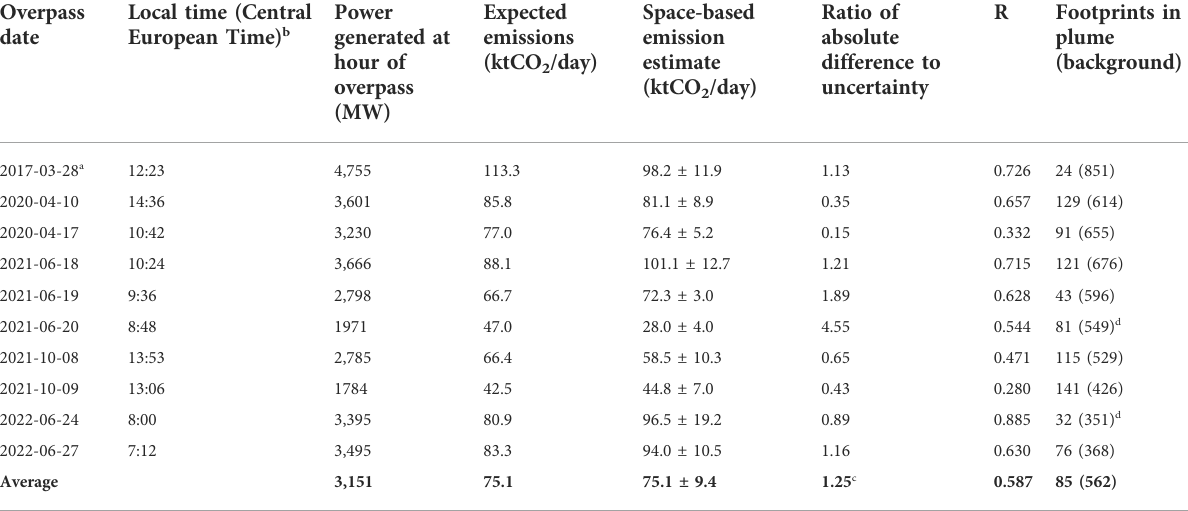
TABLE 1 Be ł chat ό w CO 2 emission estimates on multiple dates compared with reported power